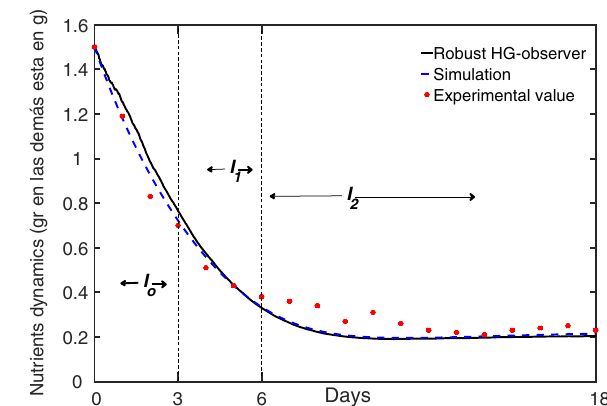
Figure 4: Flow diagram and design of a type of algal biomass turbidity sensor. ( a ) Noninvasive and sterile biomass sensor, ( b ) pilot photobioreactor provided to pumping the algal biomass, ( c ) light intensity sensors used for measuring turbidity at light TEMT 6000, and ( d ) 5 mm high luminosity LED.